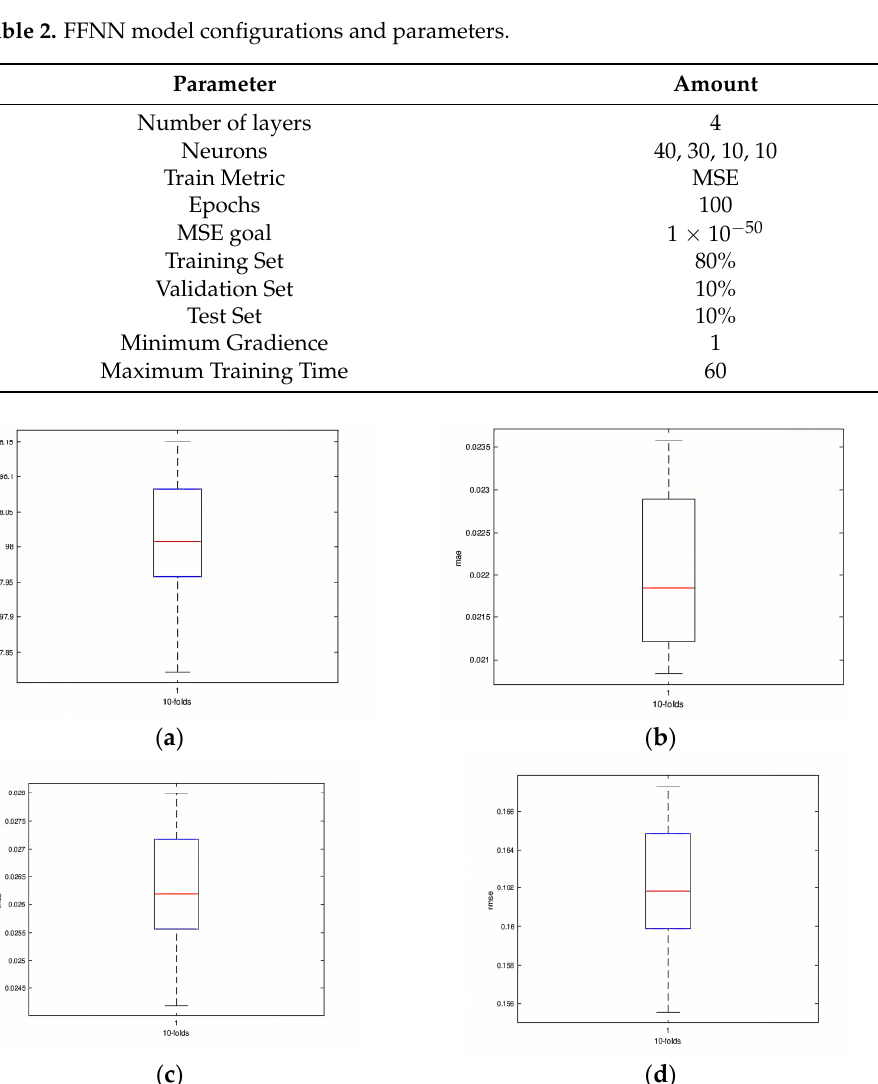
Figure 4. 2SFNN of falling precision with the 10-cross valuation (no optimization): ( a ) accuracy; ( b ) MAE; ( c ) MSE; ( d ) RMSE.